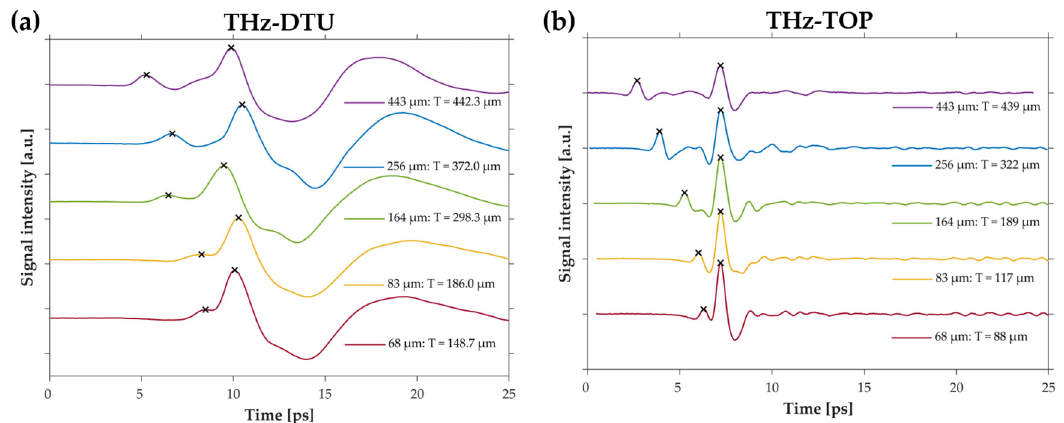
Figure 5. THz-TDS measurements of paper samples with 68–443- μ m thickness. ( a ) THz-DTU measurements, showing a good separation of the peaks for the 443- μ m and 256- μ m papers, but an increasing overlap for paper thicknesses of 164 μ m and thinner. ( b ) THz-TOP measurements of the same samples, showing seemingly good separation for all measurements, but a large discrepancy in the estimated thickness for the thinner samples.